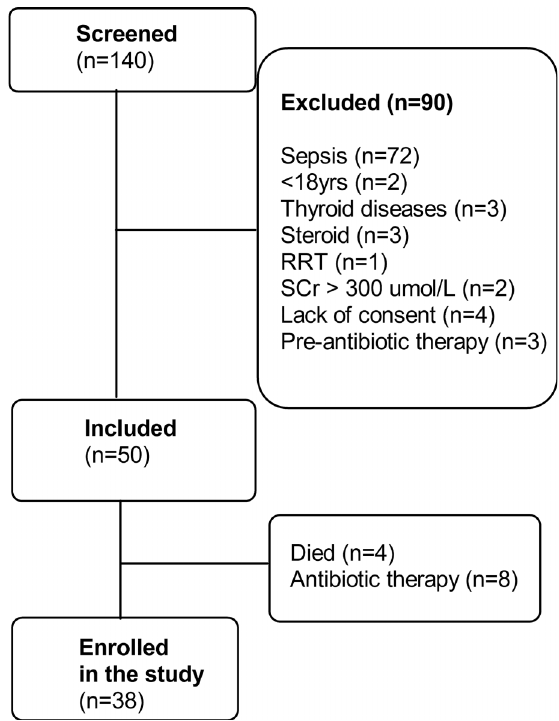
Figure 1 - Flow chart depicting the selection process. RRT: renal replacement therapy; SCr: serum creatinine.